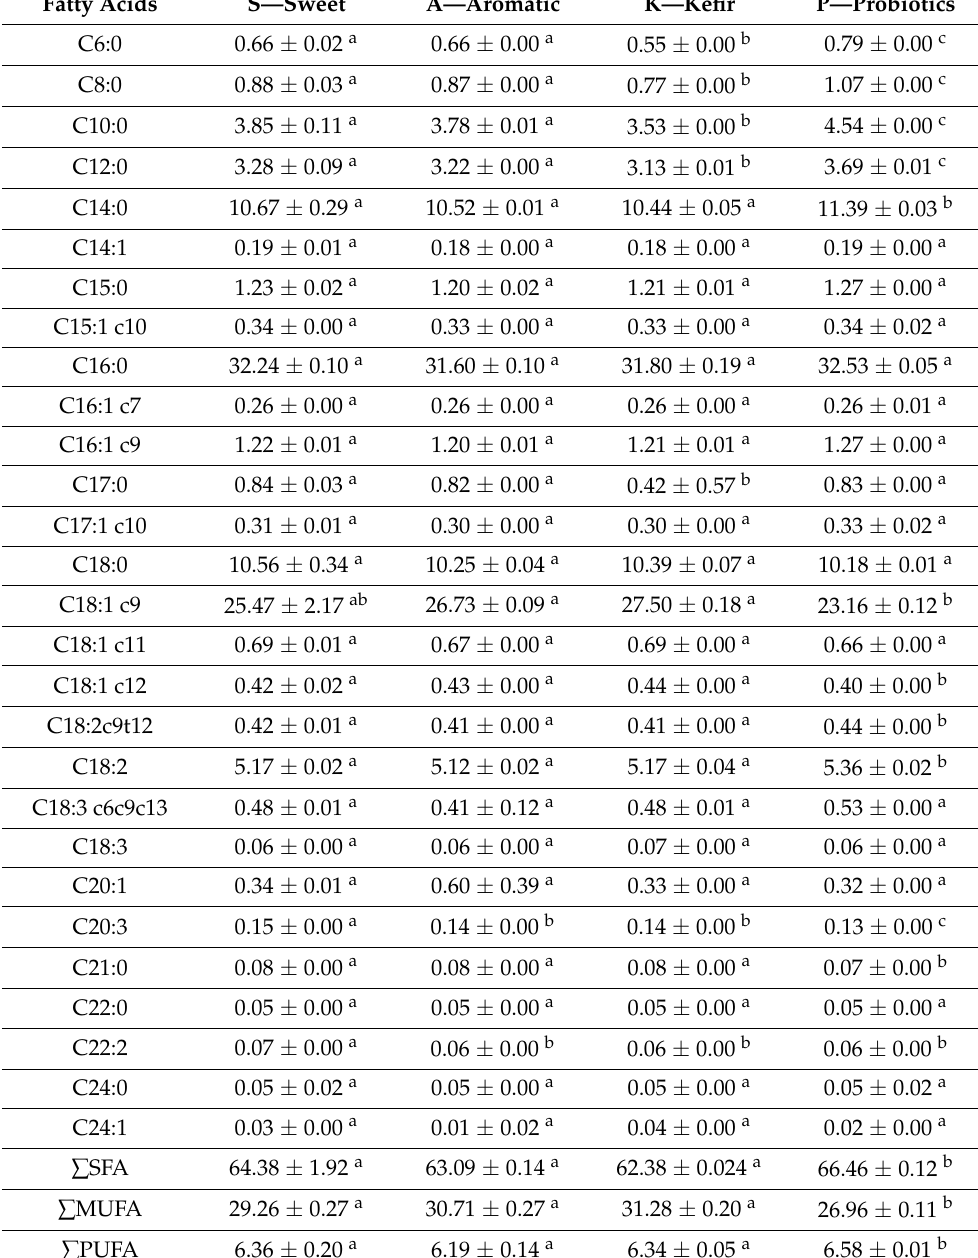
Table 5. Fatty acid profiles of sheep’s butters produced with sweet cream and with cream fermented with different starter cultures. Average values and standard deviation. Different superscript lowercase letters in each row (a,b,c) indicate significant differences ( p < 0.05) between products. Fatty Acids